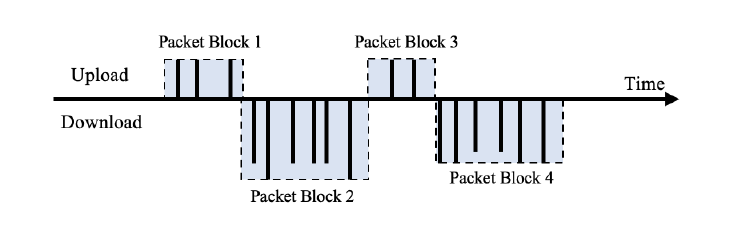
Figure 2. Flow model-based Packet